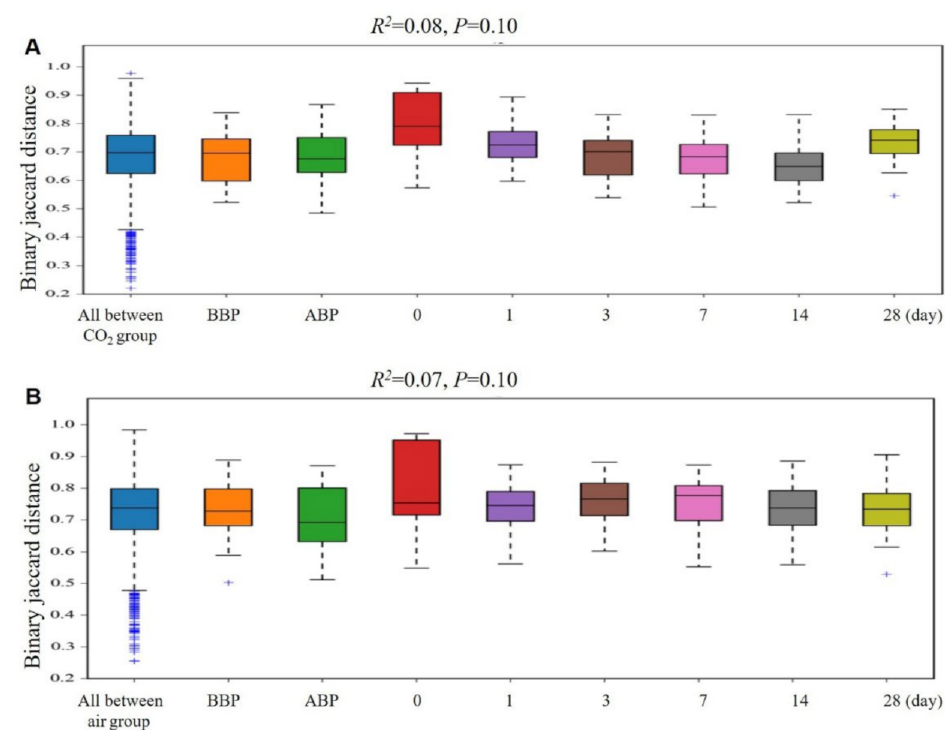
Figure 4. Changes of the gut microbiota composition (beta diversity) in the CO 2 group and the air group. No differences in the gut microbiota composition after colonoscopy within the CO 2 group ( A ) and the air group ( B ) or between two groups at each time point (data not shown). CO 2 , carbon dioxide. BBP, before bowel preparation. ABP, after bowel preparation. 0, 1, 3, 7, 14, 28 indicates the day after colonoscopy and 1, 3, 7, 14, 28 days after colonoscopy.